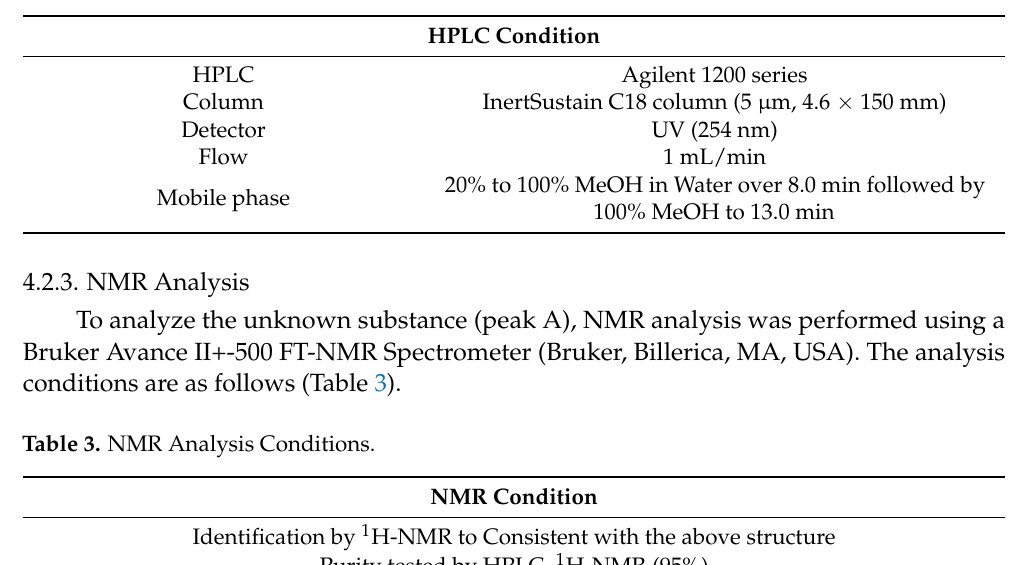
Table 2. The marker components HPLC Analysis Conditions.